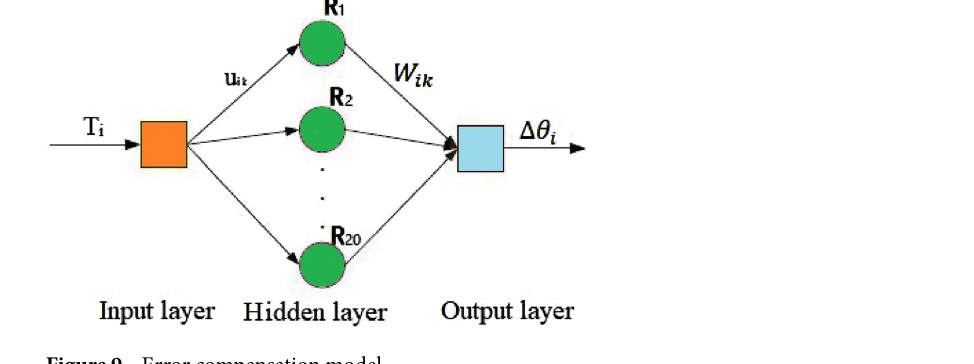
Figure 9. Error compensation